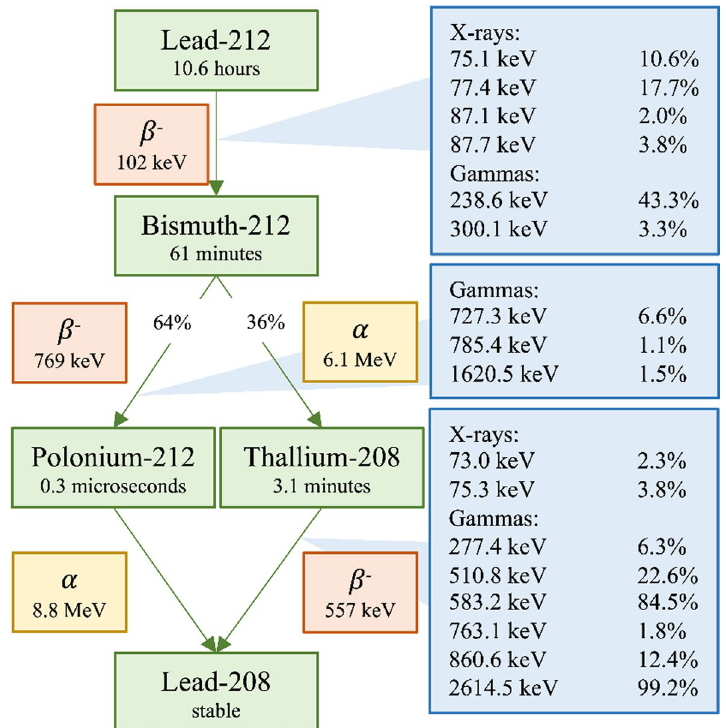
Fig. 1 Decay scheme of 212 Pb. The mean alpha and beta energies are included. The relevant photons emitted and their energies are added to the transition. Photons with emission probabilities smaller than 1% per 212 Pb decay or with energies below 70 keV are not included. The data are taken from ICRP 107